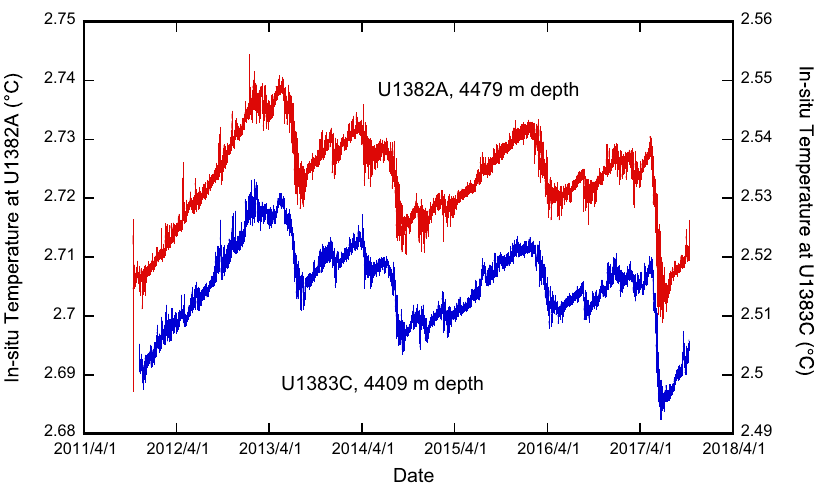
Fig. 2 Six-year records of temporal variability of bottom-water temperatures at Holes U1382A and U1383C. Hole U1382A temperatures are shown in red, Hole U1383C temperatures In blue. As noted in the Methods section, there is an absolute calibration offset between sensors, but relative variations track remarkably